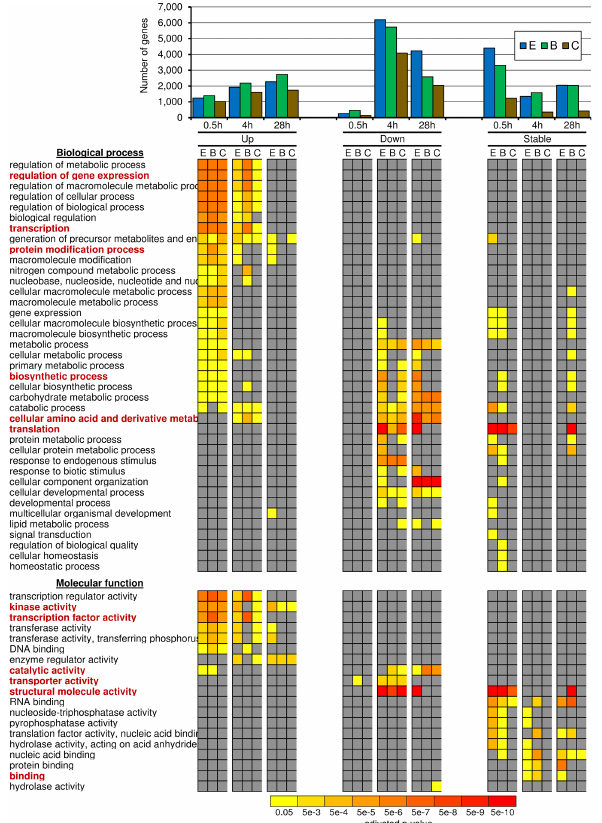
Fig 3. Number and GO enrichment analysis of up-, down-, and stable-regulated genes in flood- tolerant Embrapa 45 (E), flood-sensitive BR 4 (B), and in both soybean cultivars (C). Differentially expressedgenes: fold-change (cid:21) 2 (up), (cid:20) -2(down); adj. p (cid:20) 0.01; RPM (cid:21) 9 (control or stress datasets). Stable-regulated genes: fold-change (cid:20) 1.1 or (cid:21) -1.1; RPM (cid:21) 9 (control and stress datasets). RPM (cid:21) 9: at least 20 reads in all datasets. Red GO names are cited in the